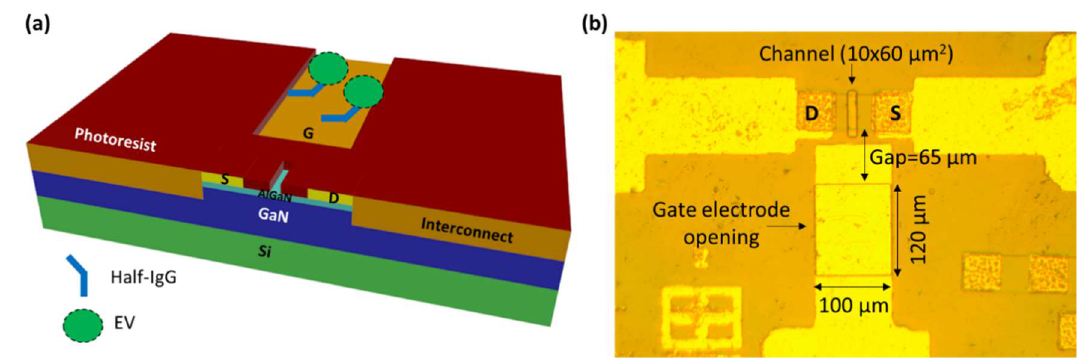
Figure 1. ( a ) Schematic illustration of AlGaN/GaN HEMT biosensor for EV quantification. ( b ) Top view image of GaN HEMT biosensor showing the sensing region comprised of gate electrode opening and transistor channel opening separated by 65 µm gap.